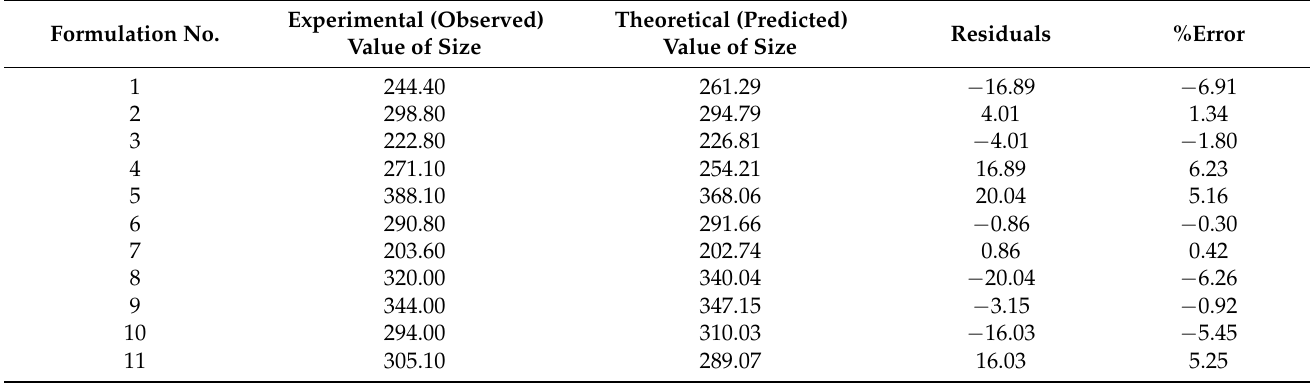
Table 6. Experimental and theoretical values with residuals of the response